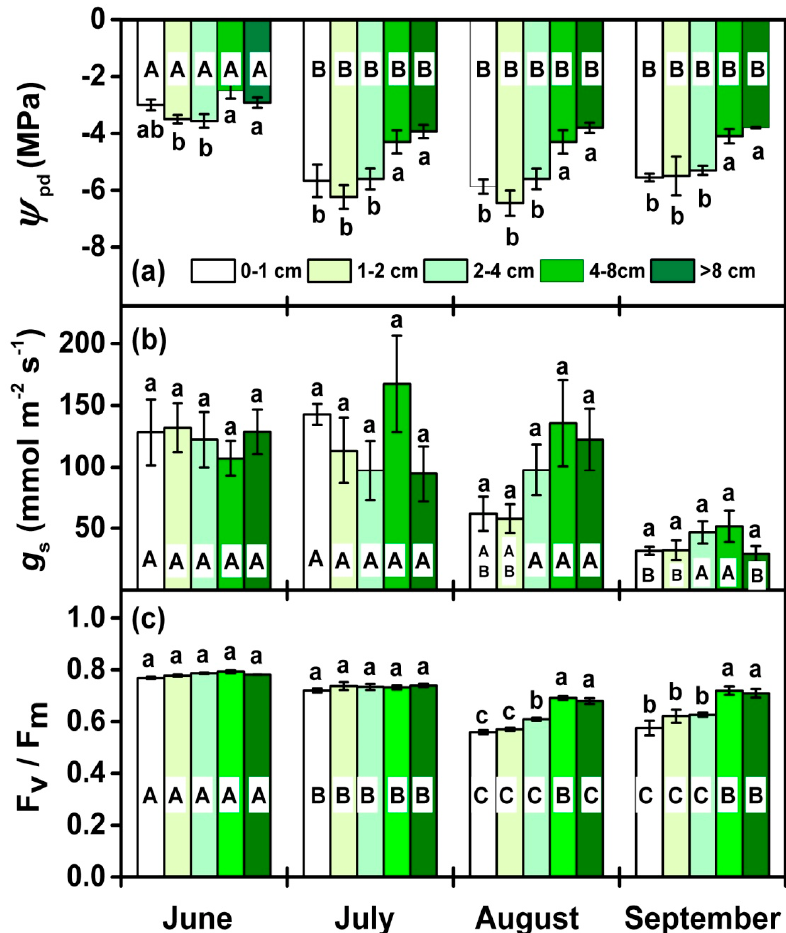
Figure 3. Predawn leaf water potential ( Ψ pd , a ), stomatal conductance (g s , b ) and maximum photochemical efficiency (Fv/Fm, c ) variation of H. ammodendron across basal stem diameter class during the growing season (means ± SE). The capital letter showed the significance difference of the same diameter groups across the growing season from June–September, and the lowercase letter showed the significance difference among the diameter groups at the same trial day (All p -values < 0.05). Data are mean ± 1 SE ( n = 5).